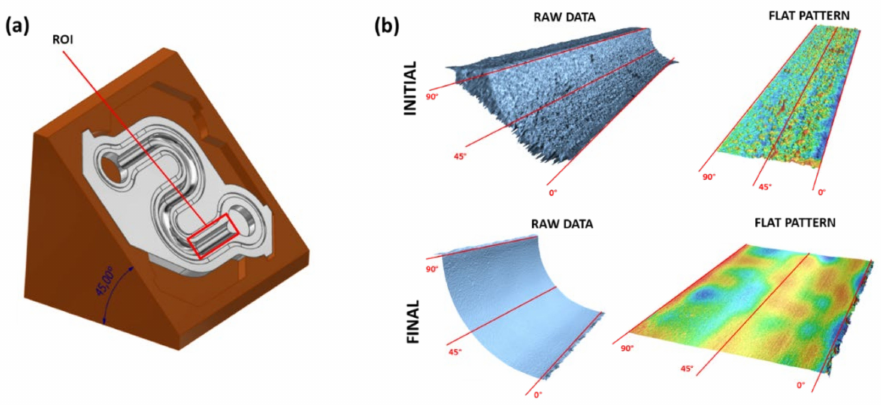
Figure 8. S-shape, Ra measurements (initial/final): ( a ) setup and ROI; ( b ) segment